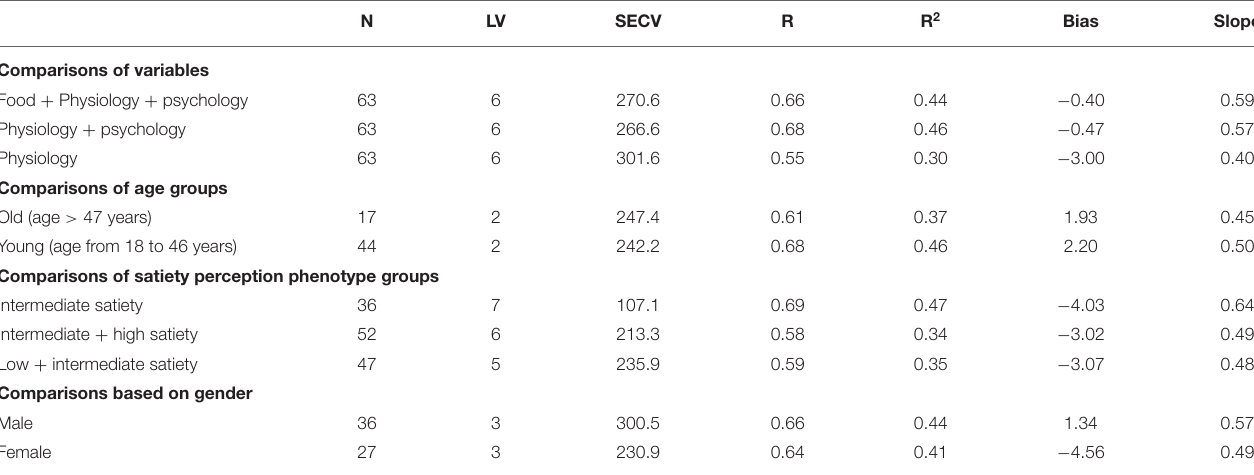
TABLE 2 | Partial least squares regression statistics for the prediction of satiety using different combinations of